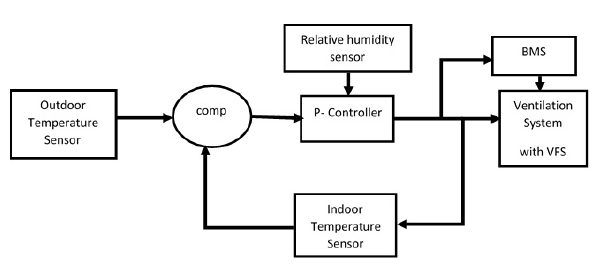
Fig. 7. Block diagram shows the working principle of the proposed night ventilation